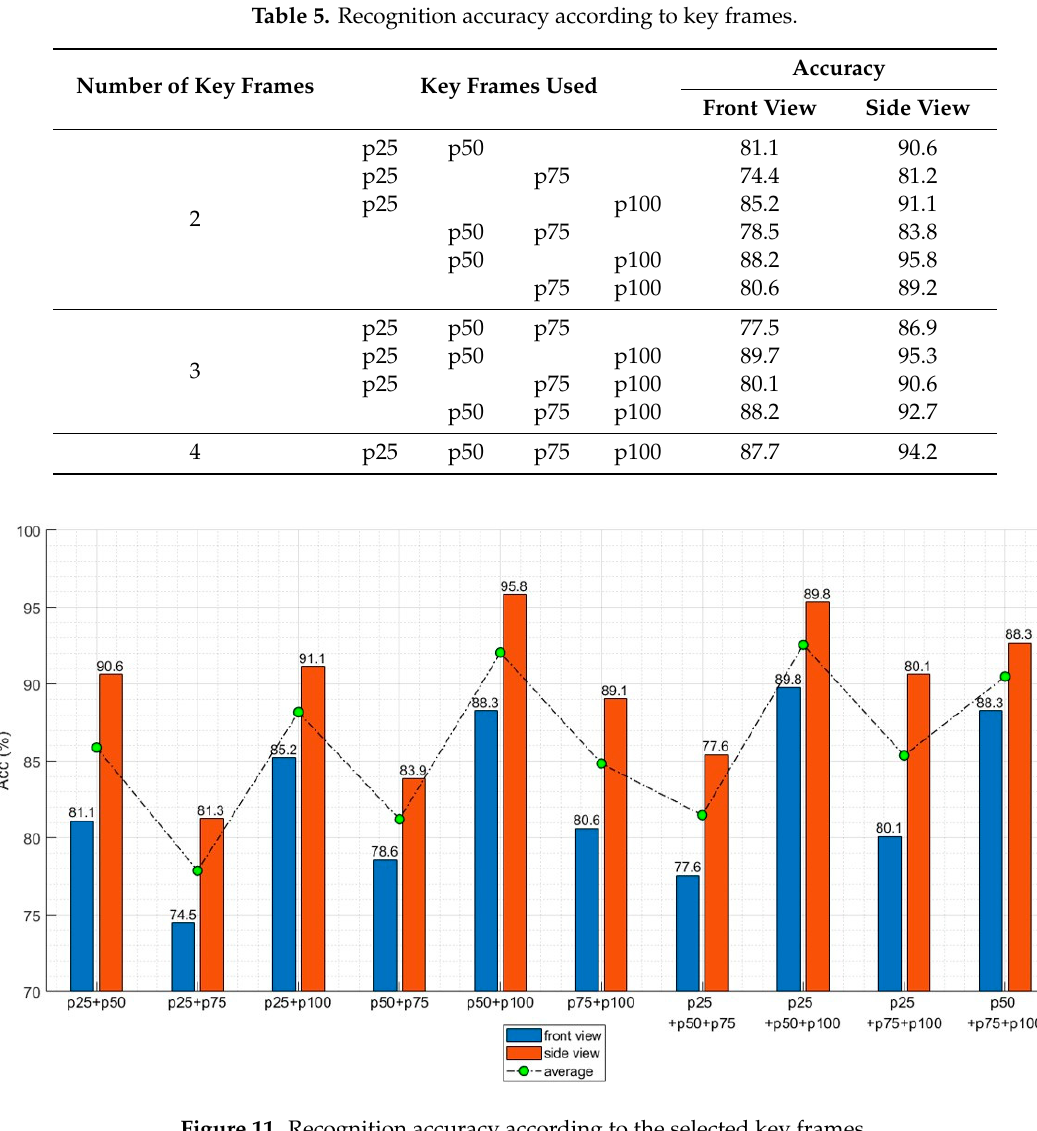
Table 6. Average recognition accuracy by key frames.